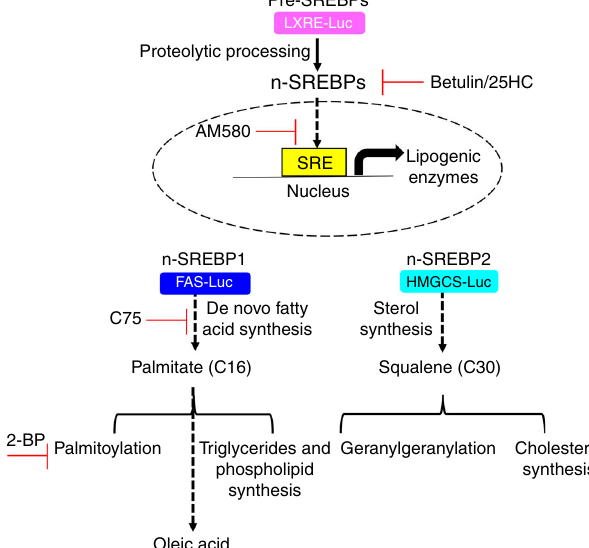
Fig. 7 Schematic diagram showing the proteolytic processing of precursor SREBPs to generate n-SREBPs, downstream effector pathways (i.e. n- SREBP1-mediated fatty acid synthesis and n-SREBP2-mediated cholesterol synthesis), the positive control inhibitors and their pharmacological targets, and reporter gene constructs that were used in this